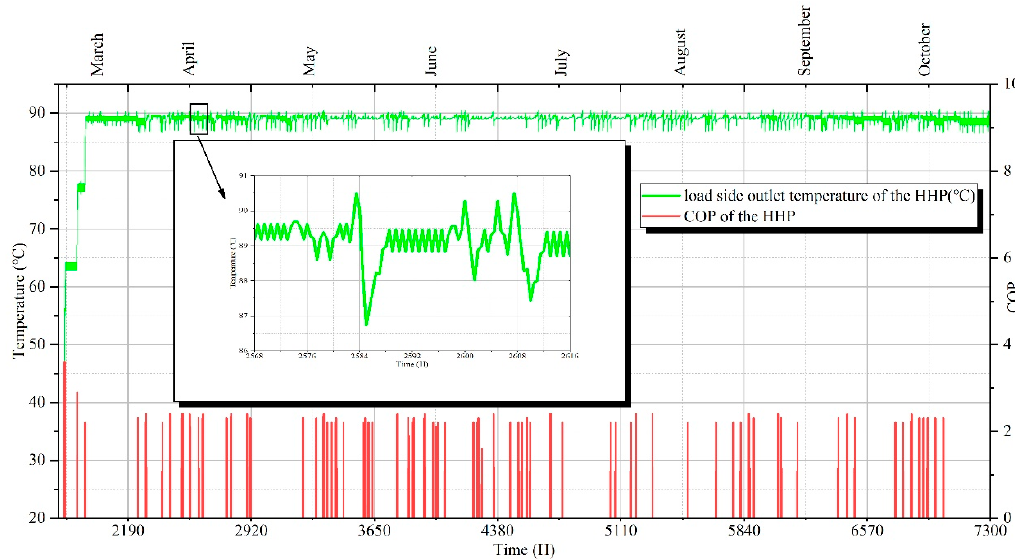
Figure 15. COP and load side outlet temperature of the HHP during cooling mode.